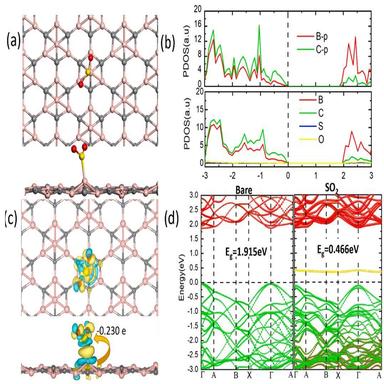
(a) Top and side view of the SO2 adsorbed electronic structure. (b) Density of state before and after adsorption. (c) Differential Charge density of the SO2/B4C3 configuration. (d) Band structure of pristine and SO2-adsorbed B4C3.